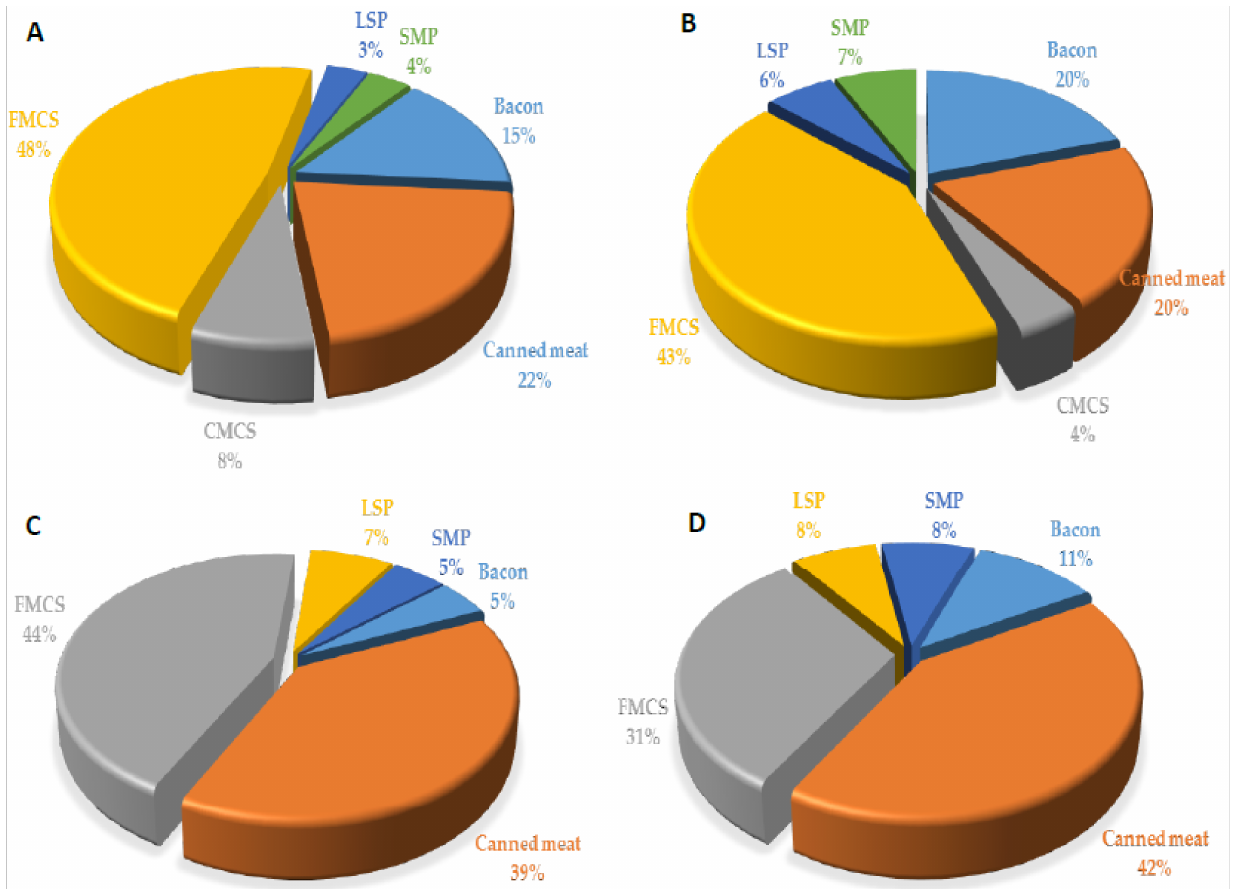
Figure 5. Contribution (%) of the most important food groups of processed meat products to dietary exposure of toddlers 1–3 years (( A )—male and ( B )—female) and children 3–9 years (( C )—male and ( D )—female) to phosphorus ion. CMCS—coarsely minced cooked sausages, FMCS—finely minced cooked sausages, LSP—liver sausage and pate, SMP—smoked meat